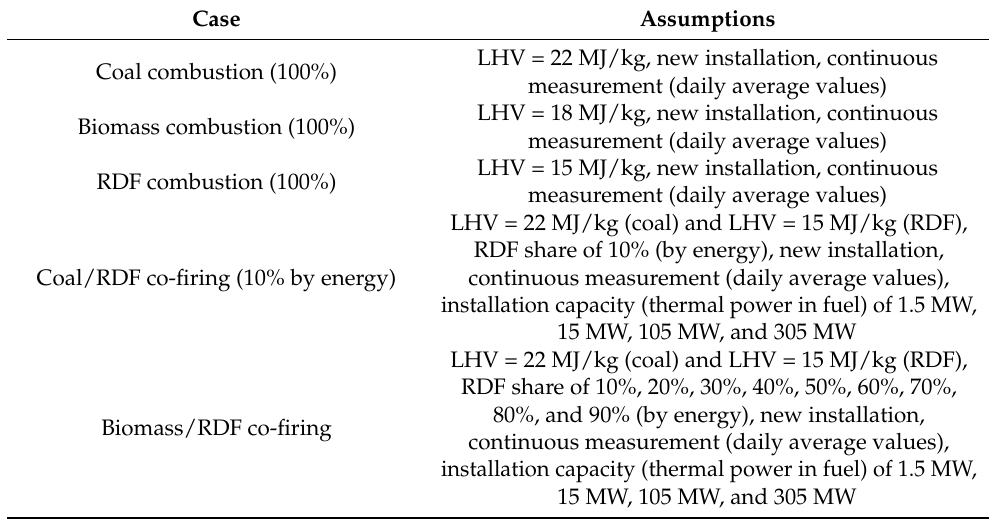
Table 1. The assumptions during the calculation of NO x emission standards in different cases. Case